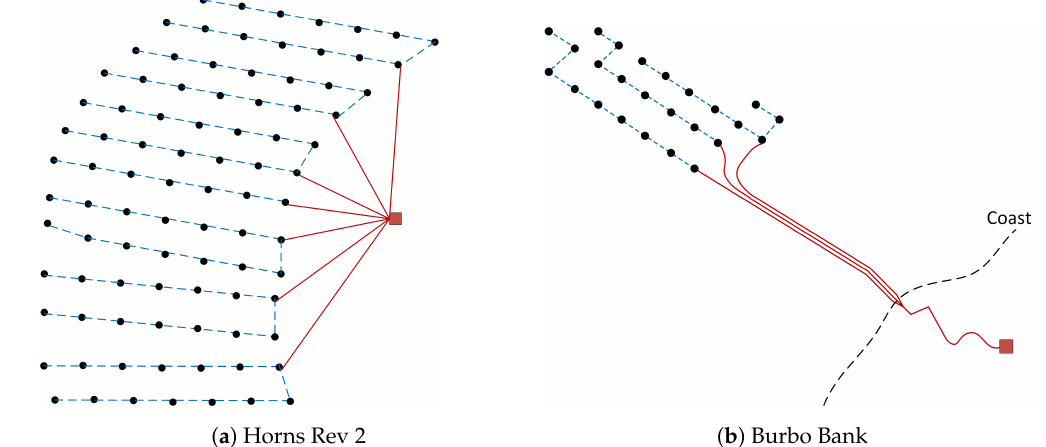
Figure 10. Wind power plant